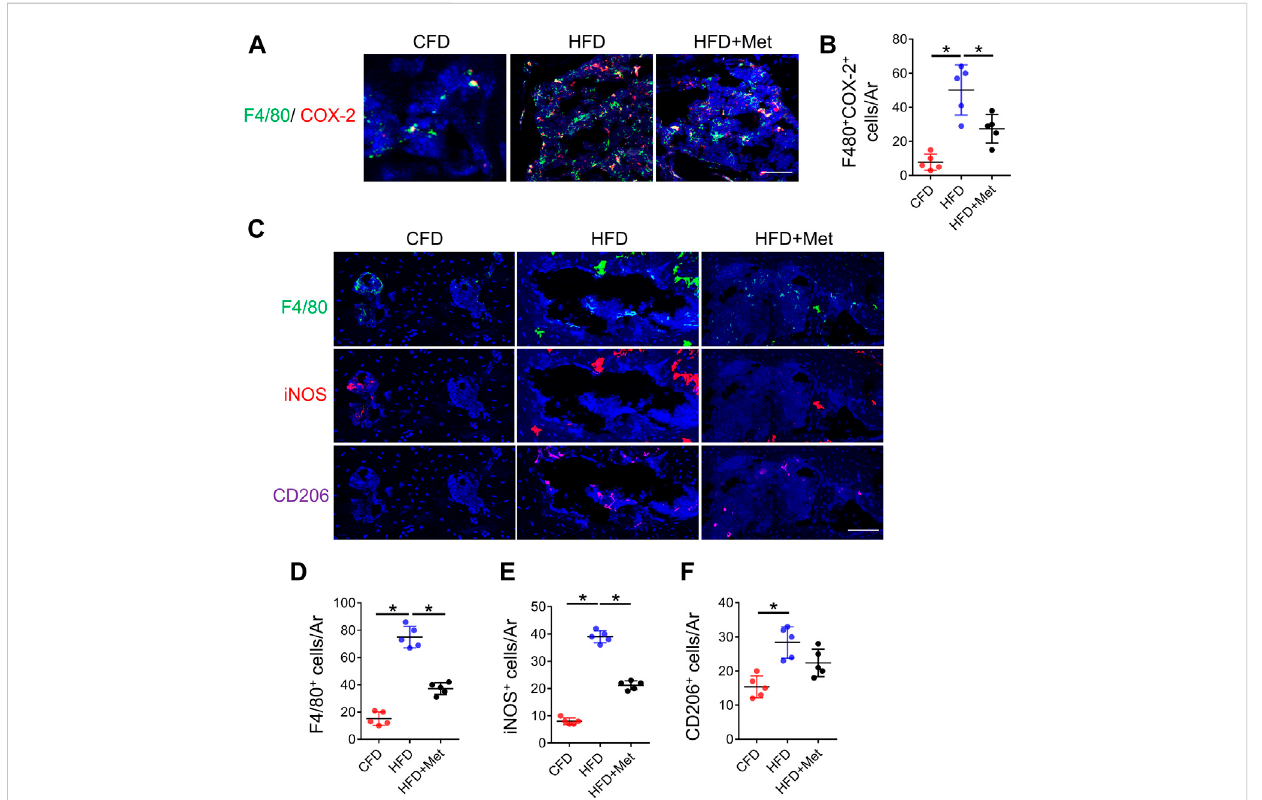
FIGURE 3 Metformin reduces the number of COX-2 + macrophages in subchondral bone. Three-month-old C57BL/6 mice were fed a standard chow-food diet(CFD), HFD, or HFDwith metformin (HFD + Met) for 3 months. n=6 mice pergroup. (A, B) Immuno fl uorescence double stainingof COX-2 (red)and F4/80 (green) in (A) and quanti fi cation of the number of F4/80 + COX-2 + cells in subchondral bone sections in (B) . (C – F) Immuno fl uorescence staining of F4/80(green), iNOS(red), and CD206 (purple) in (C) , quanti fi cation of the number of F4/80 + cells in subchondral bone sections in (D) , quanti fi cation ofthenumberofiNOS + cellsinsubchondralbonesectionsin (E) ,andquanti fi cationofthenumberofCD206 + cellsinsubchondralbonesectionsin (F) .All data are shown as means ± standard deviations. * p < 0.05. Statistical signi fi cance was determined by one-way